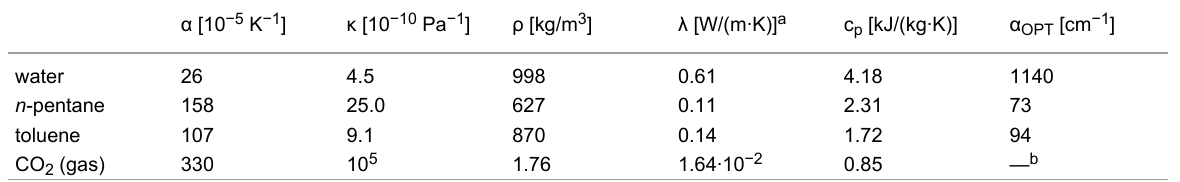
Table 1: Comparison of material properties of different hydrocarbons, water and CO 2 (300 K, 10 5 Pa). The absorption coefficients α OPT were calcu- lated in the bandwidth 3–5 µm using data from [28-30].